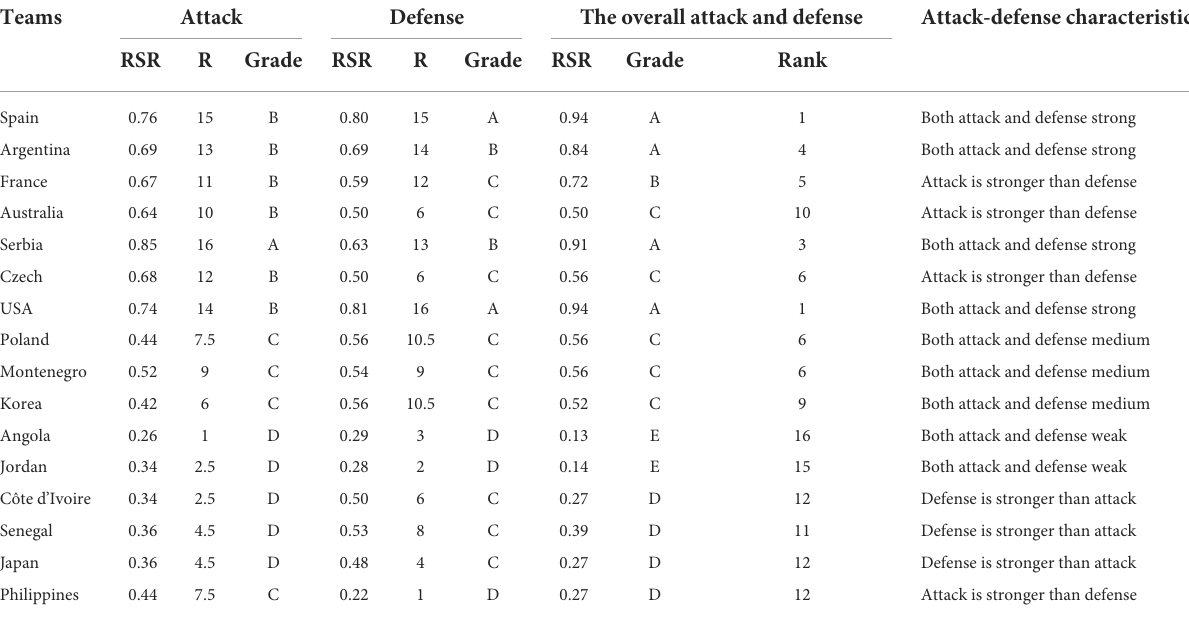
TABLE 5 The RSR value and grade of the overall attacking and defensive performance between the top eight and bottom eight teams. Teams